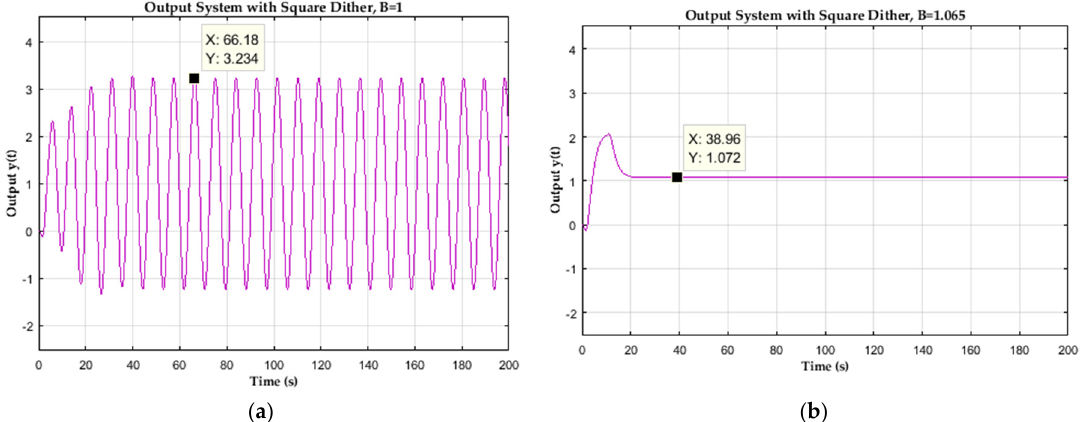
Figure 9. Closed-loop step response with Square wave dither injection, ( a ) with dither amplitude B = 1, ( b ) B = 1.065. When B = 1, the limit cycle amplitude is 2.234 units.